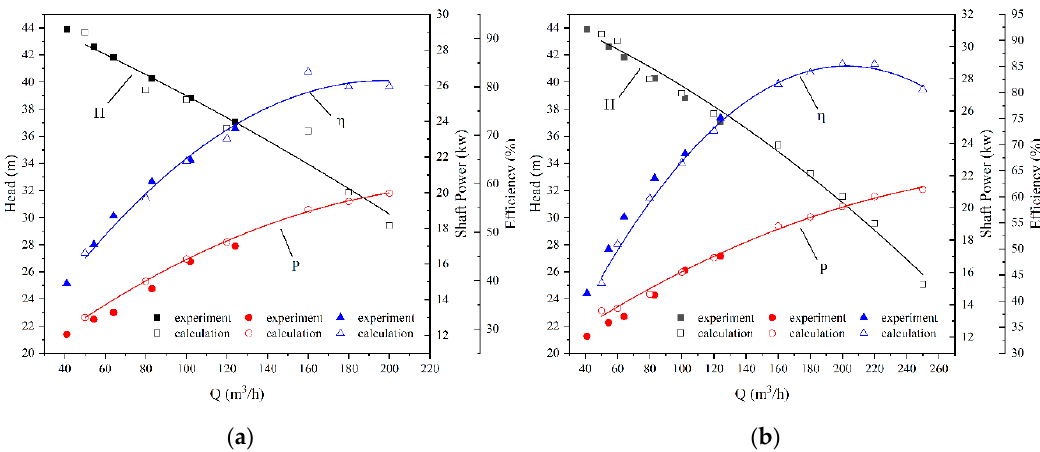
Figure 6. Performance curve of the slurry transport pump: ( a ) slurry condition; ( b ) water condition.